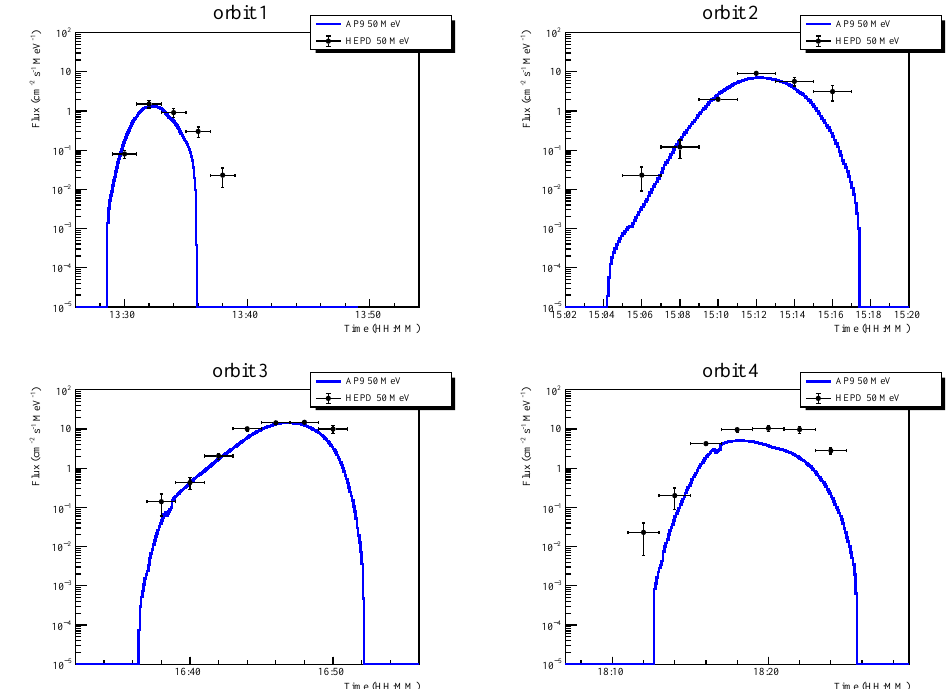
Figure 6. Time profiles (5-s resolution) of 50 MeV trapped protons estimated from the Ap9 model and compared with preliminary data of ∼ 50 MeV proton data (black circles) from the HEPD instrument on board the CSES-01 satellite. The analysis has been carried out using the procedure described in [40]. The agreement between the data and the model appears generally good, despite showing small discrepancies, especially in the peripheral regions of the SAA. Only statistical errors are